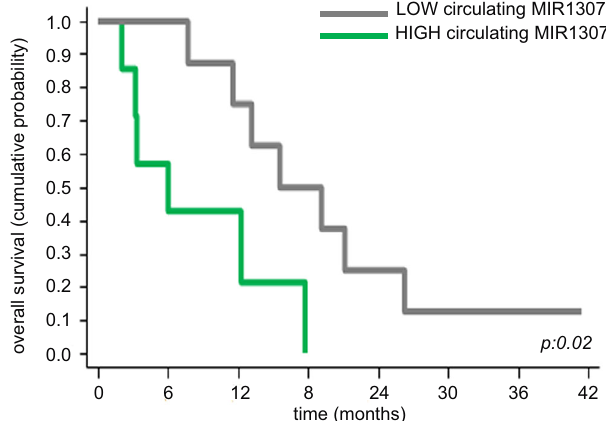
Fig. 8 Circulating MIR1307 predicts bene fi t from FOLFIRINOX. Plasma was collected from advanced PDAC patients undergoing FOLFIRINOX chemotherapy and subjected to RNA extraction. MIR1307 expression was assessed by droplet digital PCR. Cohort was split according to median MIR1307 expression in low and high MIR1307. Kaplan − Meier curve for correlation with overall survival (OS) is